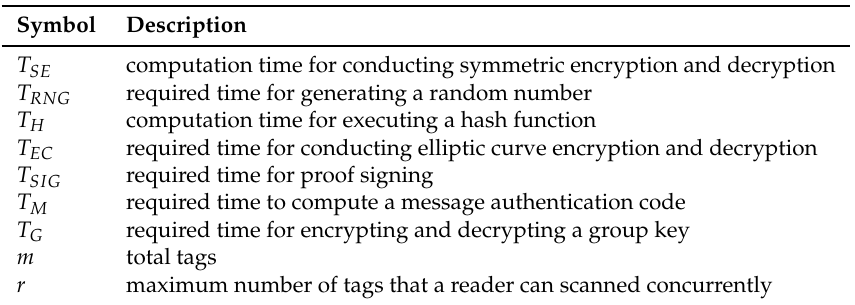
Table 3. Computational capacity symbol notations.